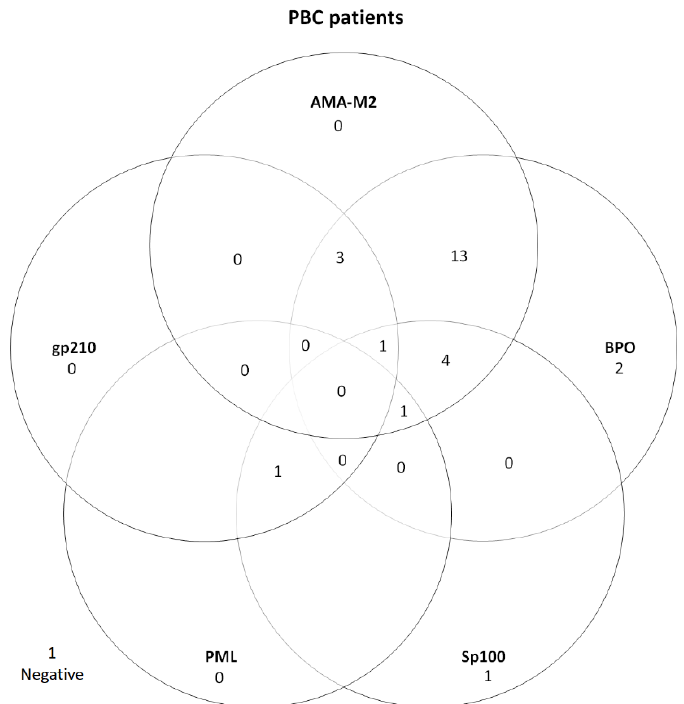
Figure 3. PBC-associated autoantibodies in PBC patients ( n = 27). One PBC patient was negative with EUROLINE immunoblot but positive with IIF rat tissue technique. AMA-M2—E2 subunit of pyruvate dehydrogenase; BPO—recombinant fusion protein of the E2-subunits of the three main M2-antigens branched-chain 2-oxoacid dehydrogenase complex [BCOADC], pyruvate dehydrogenase complex [PDC] and 2-oxoglutarate dehydrogenase complex [OGDC]); Sp100—speckled protein 100; PML—promyelocytic leukaemia protein; gp210—glycoprotein 210.